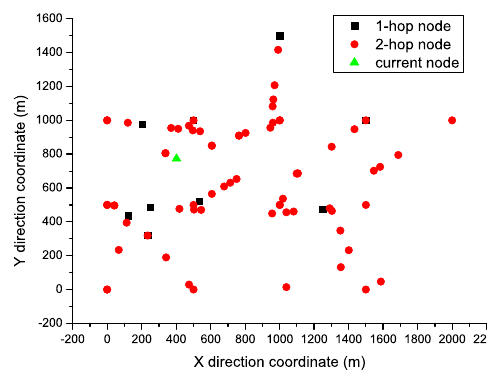
Fig.5. The locations of one or two hop